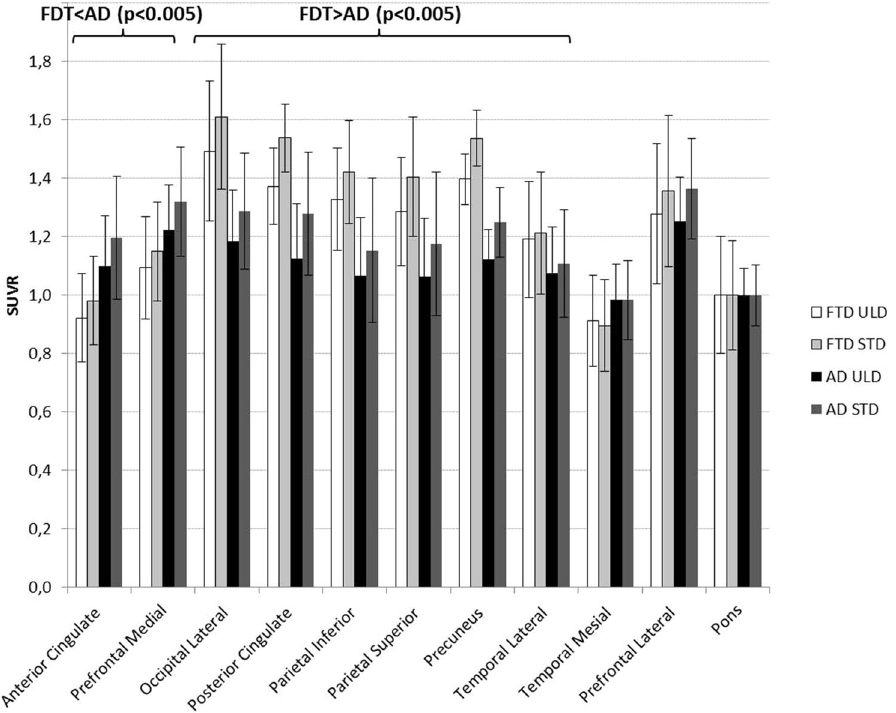
Figure 3. Mean and range SUVR for PET ULD and PET STD measured for all VOIs for patients considered as AD (15 patients) and FTD (8